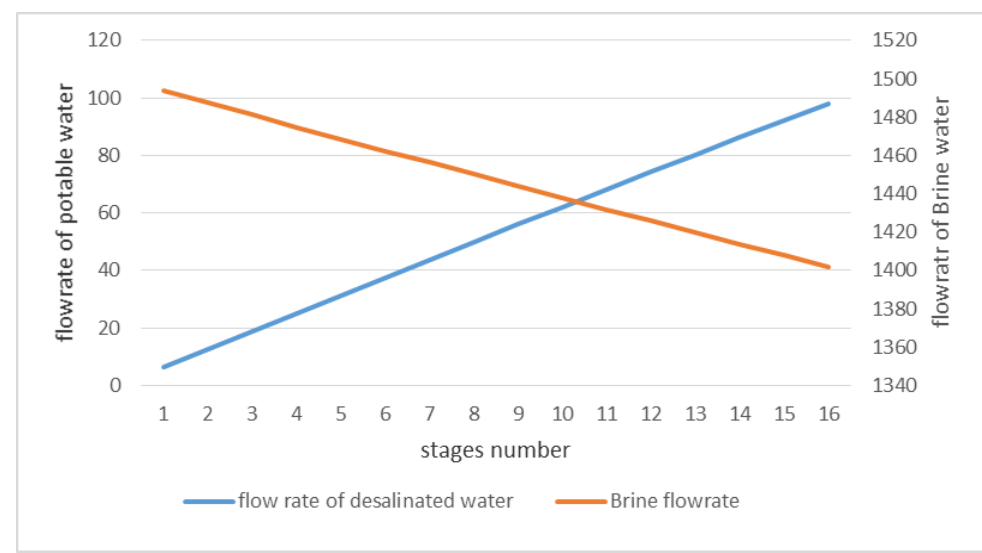
Figure 7. Flow rate distribution of brine water and distillate water in the MSF plant.